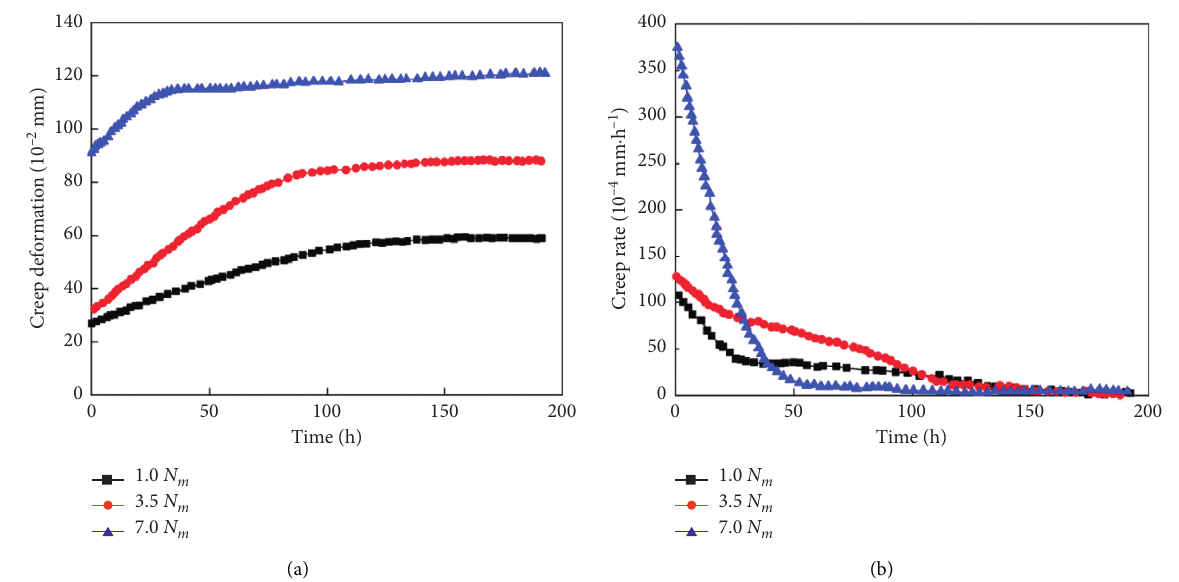
Figure 9: (a) Deformation and (b) rate of point g